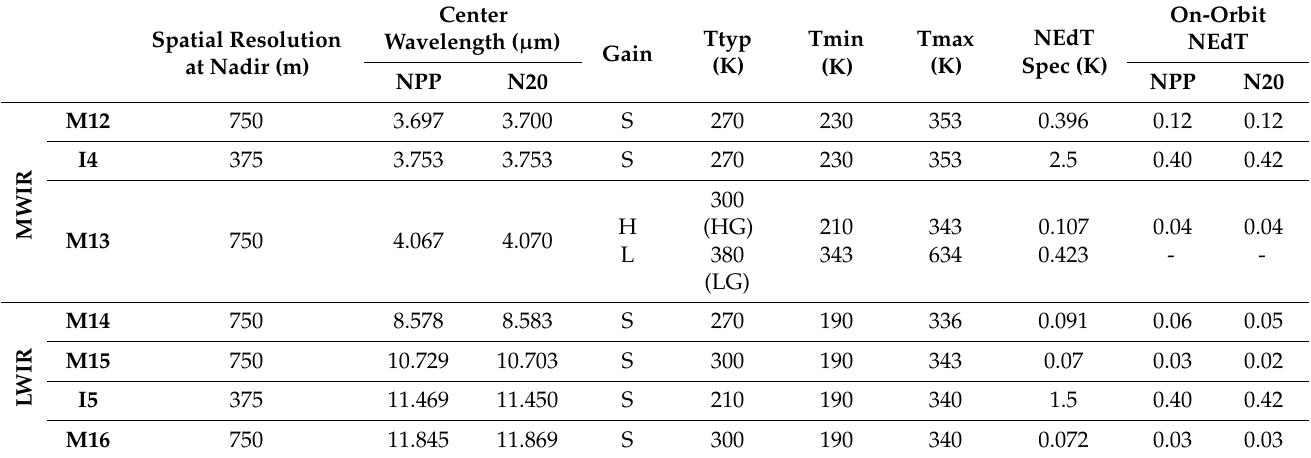
Table 1. Spectral, spatial, and radiometric characteristics of National Oceanic and Atmospheric Administration-20 (NOAA- 20, N20) and Suomi National Polar-orbiting Partnership (S-NPP, NPP) Visible Infrared Imaging Radiometer Suite (VIIRS) mid-wave infrared (MWIR) and longwave infrared (LWIR) bands. I4-I5, M12, M14-M16 are single gain (S) bands. M13 is a dual gain band (H: high gain; L: low gain). Ttyp stands for typical scene temperature; NEdT stands for noise equivalent differential temperature; NEdT Spec stands for NEdT specification at